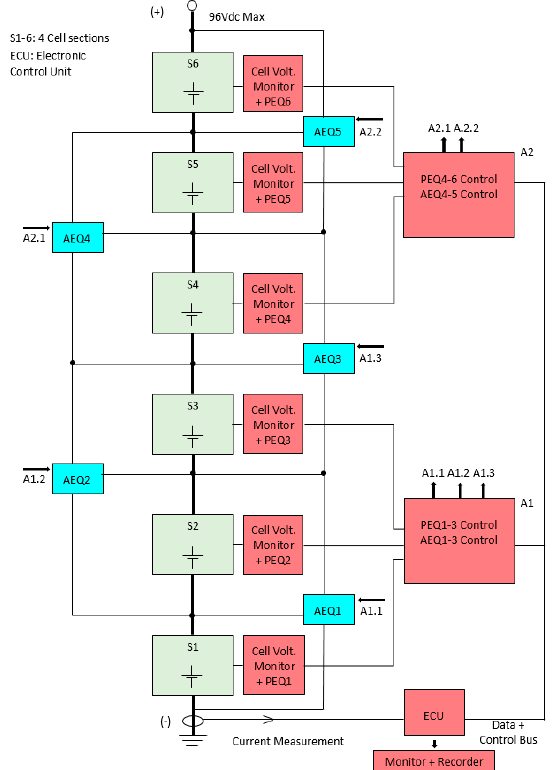
Figure 4. Block diagram for a 24 cell BEQ.